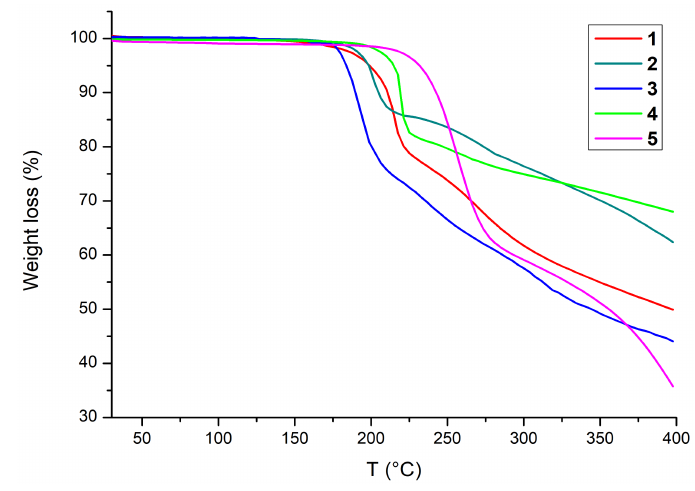
Figure 2. TGA analysis of compounds 1–5 (30–400 ◦ C, 5 ◦ C/min; N 2 ).